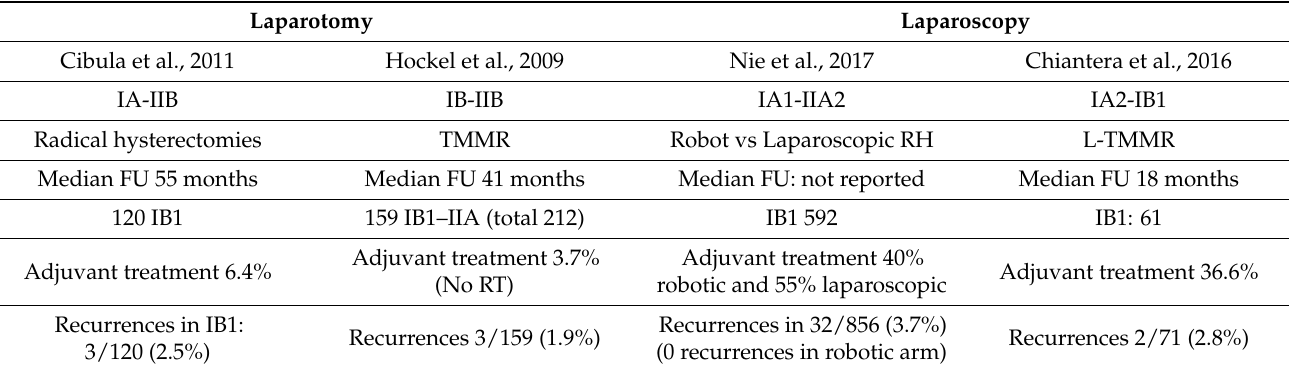
Table 2. Comparison of oncologic outcome in expert surgeon trials [24–27].